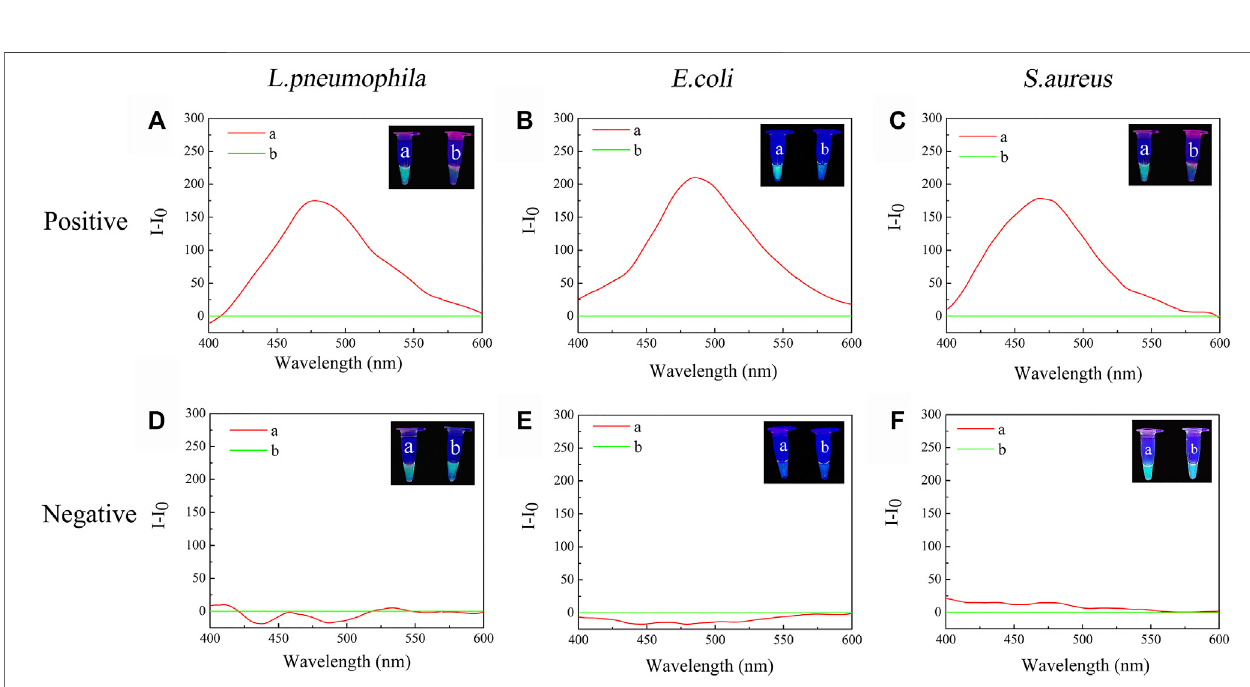
order to visualize the detection results, two identical positive samples (a, b) were prepared, the tube a was treated only by TTAPE, and the tube b was treated by TTAPE and Cas12a-RNP.